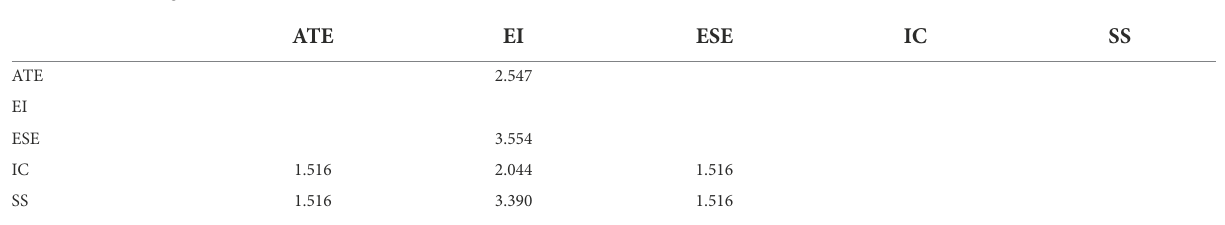
TABLE 7 Collinearity test.